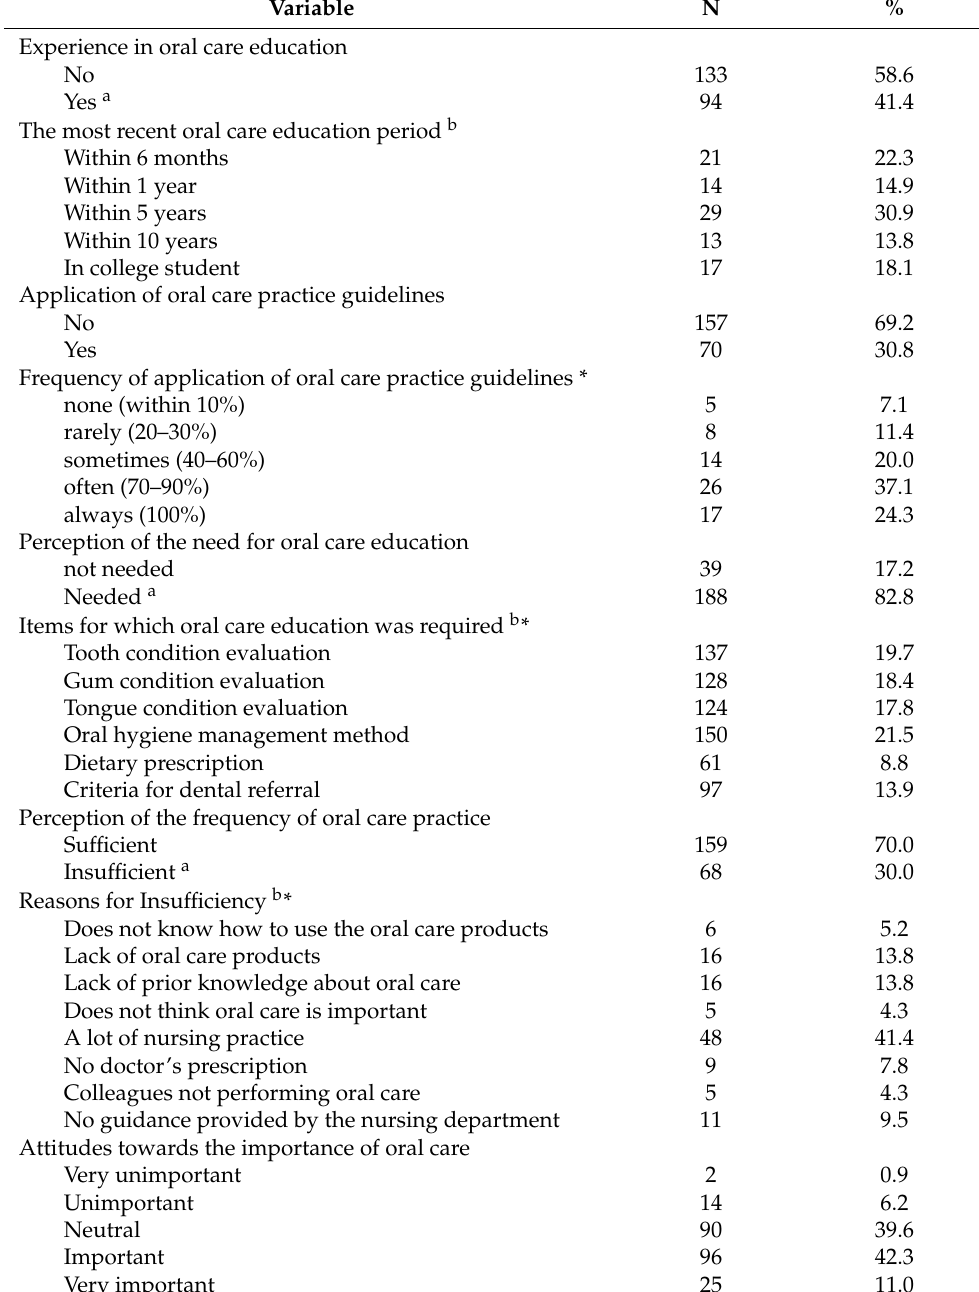
Table 3. ICU nurses’ awareness, attitudes towards oral